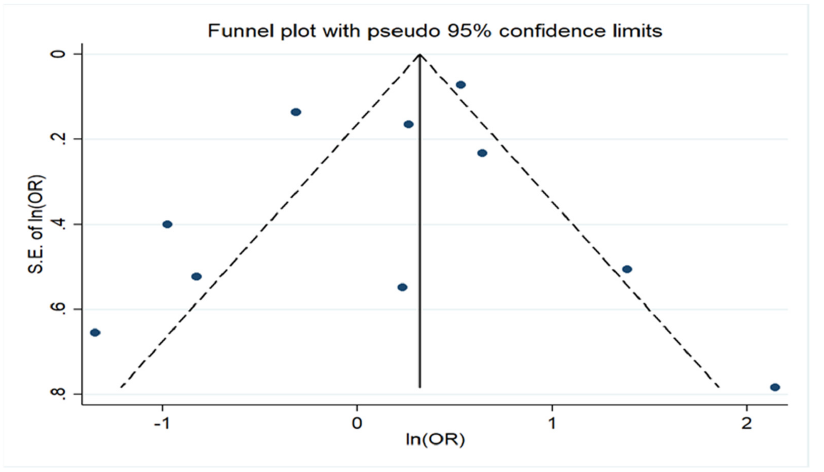
Figure 4. Funnel plot of the meta-analysis on association of preeclampsia with cerebral palsy showing evidence of publication